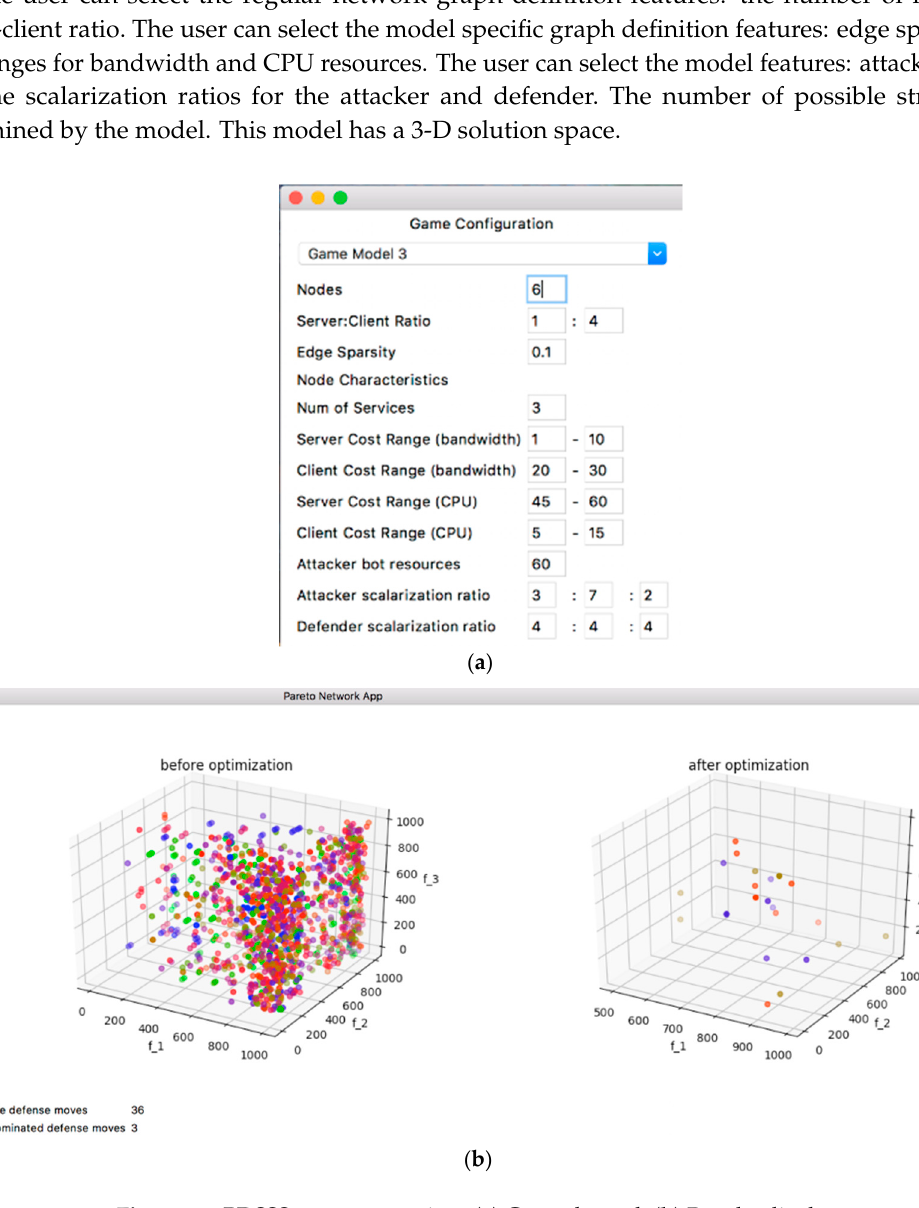
Table 7. Configuration for a complex network. Network Attributes